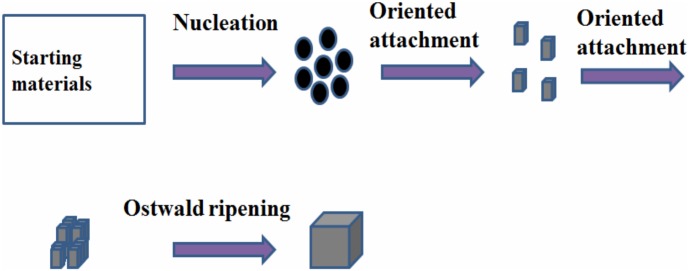
Stepwise illustration for the formation mechanism of NaNbO3 nanocubes.